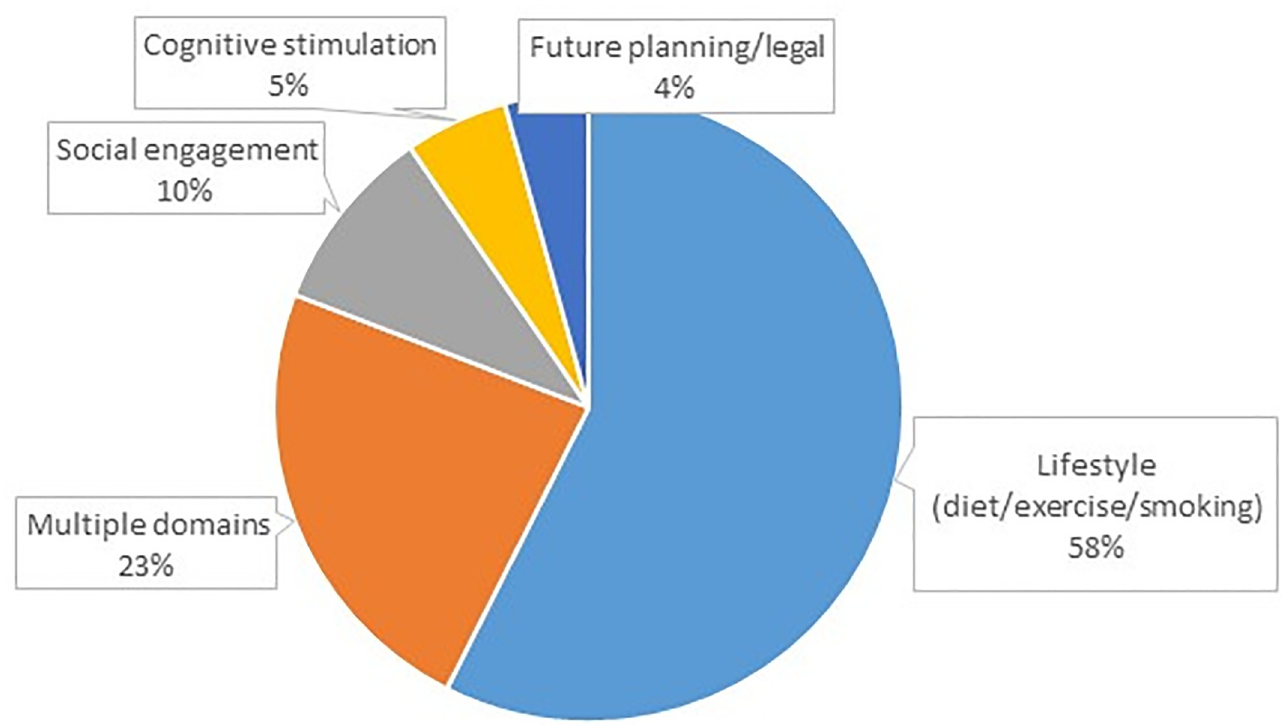
Fig 2. Behavioral changes reported by participants following dementia screening. About half of participants (49%) initiated some healthful behavioral change after receiving the results of the screening visit. The majority of participants (58%) made lifestyle changes including changing their diets, increasing exercise and smoking cessation. Other activities included increasing social engagement (10%), increasing cognitive stimulation (5%) and initiating advanced care planning (4%). Nearly a quarter of participants initiated behavioral changes in multiple domains.